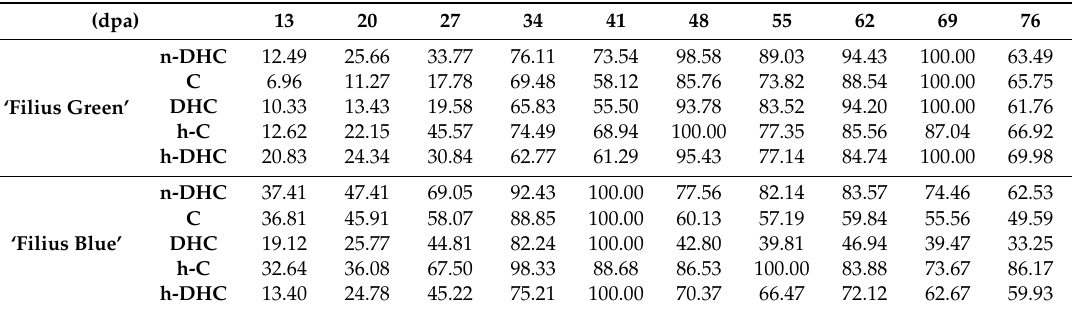
Table 2. Standardized values (%) of individual capsaicinoids during the fruit development of the two varieties